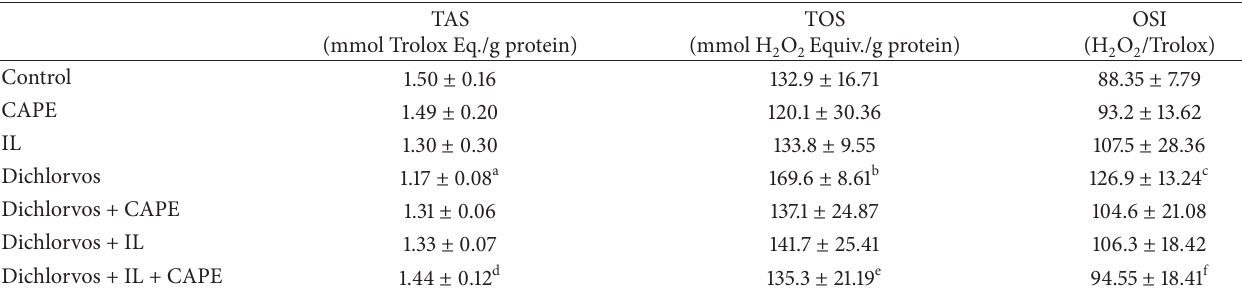
Table 1: Comparison of postmedication total antioxidant status (TAS), total oxidant status (TOS), and oxidative stress index (OSI) levels in renal tissues.